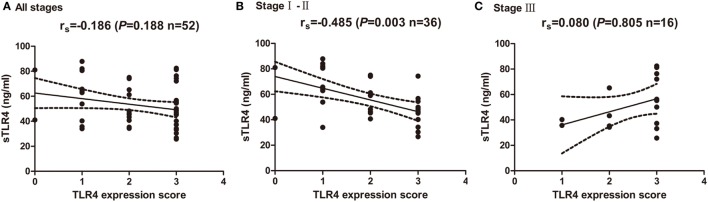
Correlation of cancer expressed toll-like receptor 4 (TLR4) level and serum soluble TLR4 (sTLR4) level. (A) No significant correlation was found between cancer expressed TLR4 and serum sTLR4 level in all the enrolled patients (rs = −0.186, P = 0.188). (B) TLR4 expression level in cancer tissues is inversely associated with serums sTLR4 level in patients with TNM stage I and II NSCLC (rs = −0.485, P = 0.003); (C) no significant correlation was found between cancer expressed TLR4 and serum sTLR4 level in stage III patients (rs = 0.080, P = 0.805). Spearman’s correlation analysis was used to determine the above correlations.